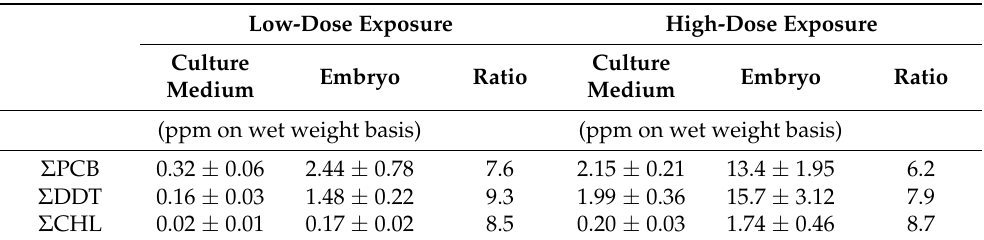
Table 1. Levels of the organohalogen compounds in the culture medium and embryos and the culture medium to embryo ratio after incubation for 48 h. Low-Dose Exposure High-Dose Exposure Culture Culture Embryo Ratio Embryo Ratio Medium Medium (ppm on wet weight basis) (ppm on wet weight basis)